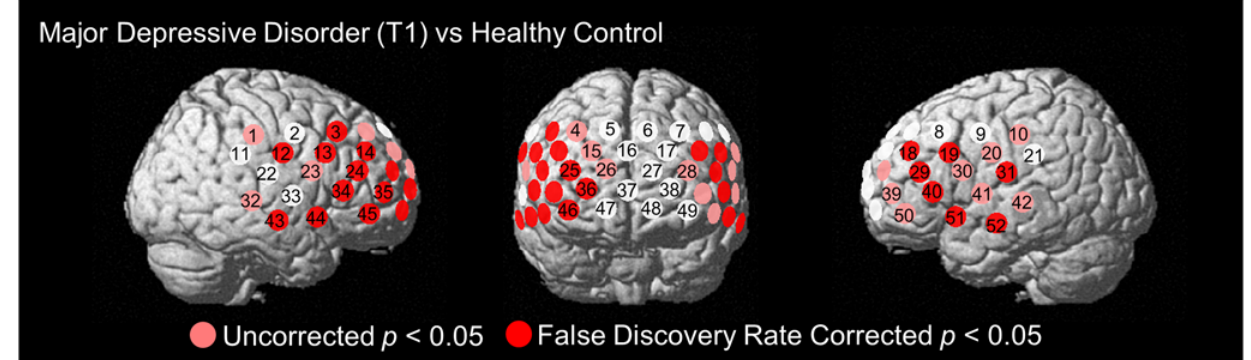
Fig 2. Results of comparison of mean [oxy-Hb] values during VFT between groups at T1 (MDD vs HC). Channels in red showed significantly decreased [oxy-Hb] activations during VFT in MDD compared with HC ( P < 0.05; FDR-corrected). T1: baseline.